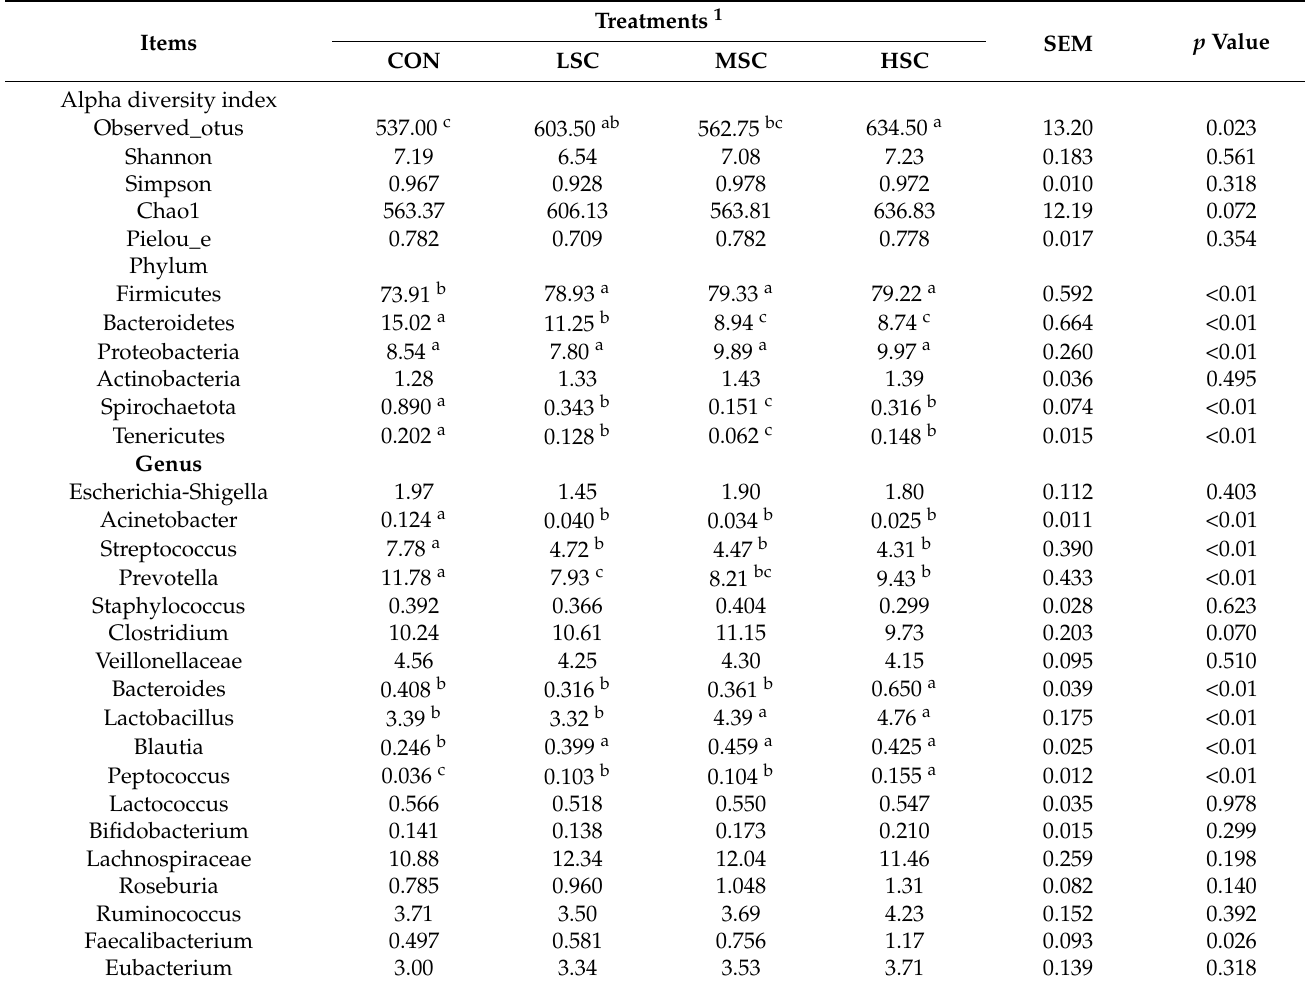
Table 7. Effects of yeast iron on alpha diversity index and the relative abundance of cecal microbia in weaned